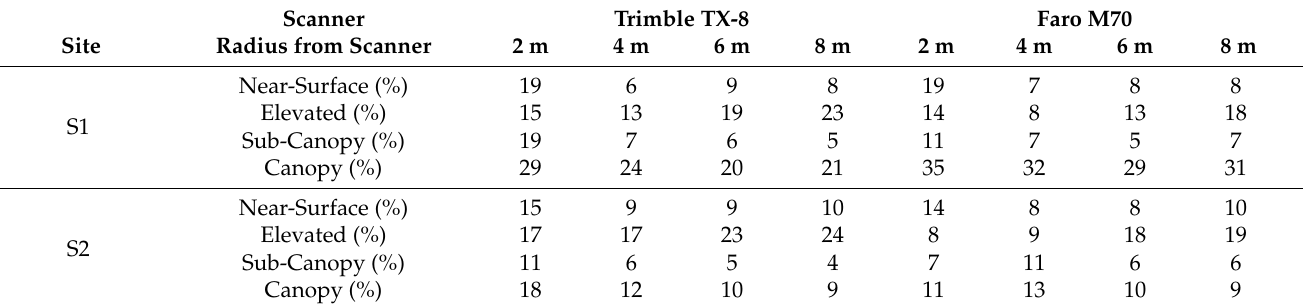
Table 3. RMSE of fuel layer cover estimates from single scan data in comparison to the estimates derived from reference 3D model within the given radius of the single scan location.